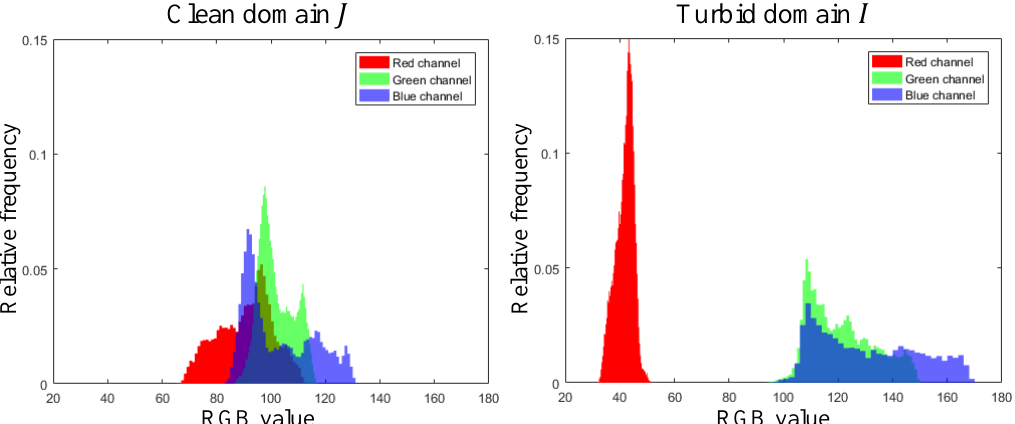
Figure 3. Average color histograms for the training dataset. ( left ): clean domain. ( right ): turbid domain.